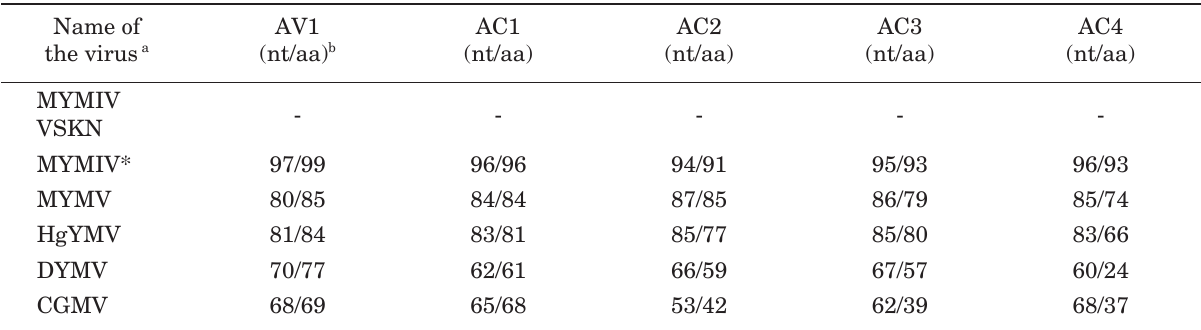
Table 2. Per cent nucleotide and amino acid sequence identity of different genes of MYMIV-VSKN with other type members of the begomoviruses.